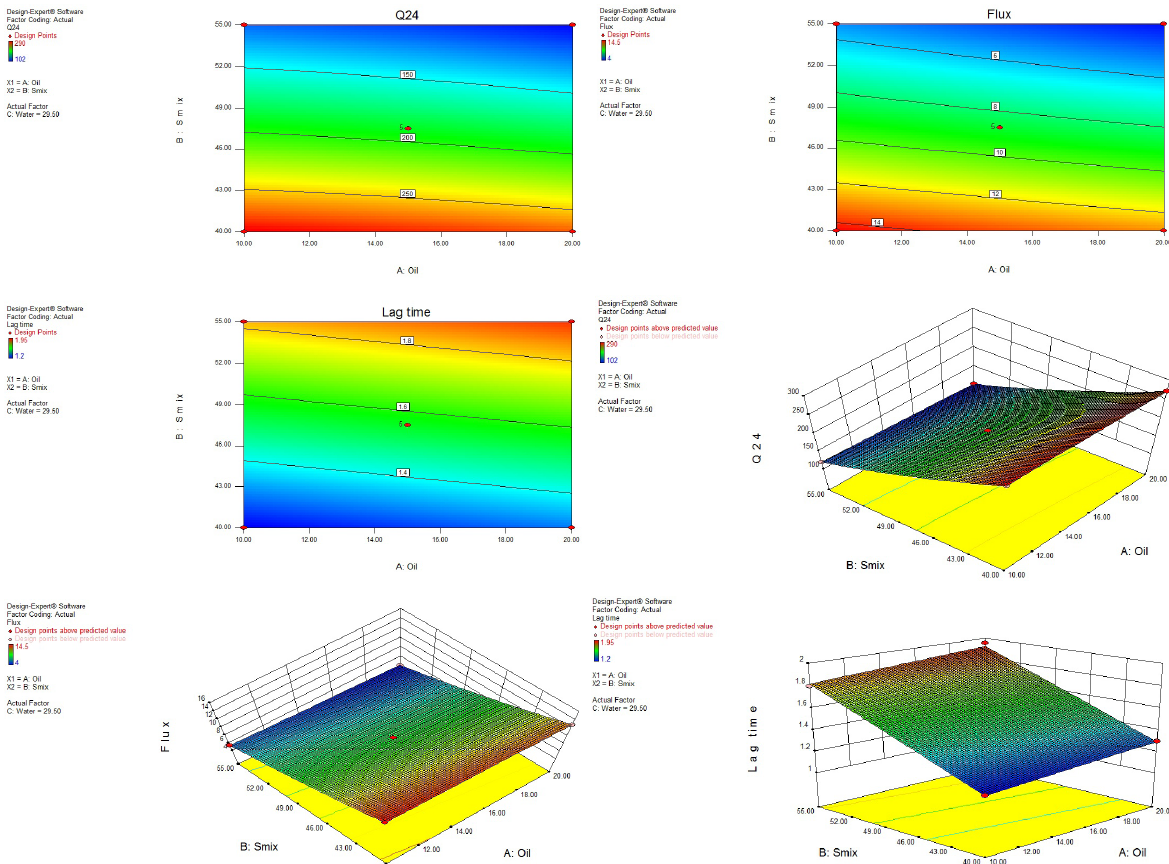
Figure 4. Contour plot showing effects (a) Q